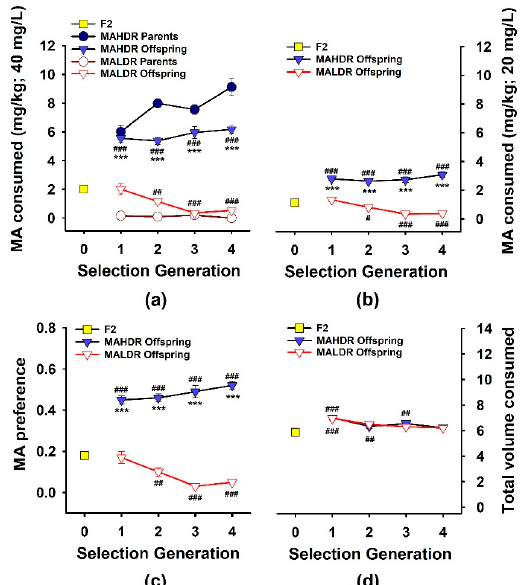
Figure 1. Bidirectional selective breeding results for methamphetamine (MA) consumption. Selection was based on amount of MA consumed when it was o ff ered as a 40 mg / L concentration vs. water. ( a ) Amount of MA consumed (mg / kg) from the 40 mg / L concentration by the founding population of C57BL / 6J x DBA / 2J F2 mice (F2; S0), and the MA high drinking (MAHDR) and MA low drinking (MALDR) selected line parent and o ff spring mice over the course of selection. ( b ) Amount of MA consumed from the 20 mg / L MA concentration for the same mice. ( c ) Preference for the 40 mg / L MA concentration (mL of MA consumed / total mL fluid consumed). ( d ) Total volume consumed from the MA and water tubes (mL), during the time when 40 mg / L MA was o ff ered. Shown are means ± SEM for the average of the second and fourth day of access to the drinking solutions for this third replicate set of MA drinking selected lines. N = 120 for the F2 mice, 56–64 / line / generation for the MAHDR and MALDR o ff spring, and 26 / line / generation for their parents. *** p < 0.001 for the di ff erence between